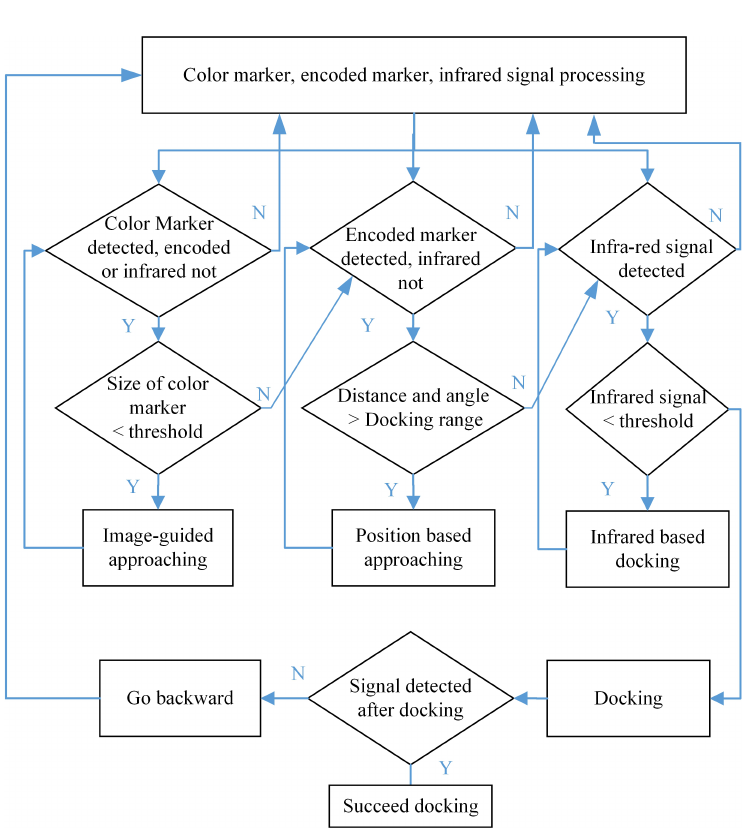
Figure 10. Control flowchart and switching scheme between different